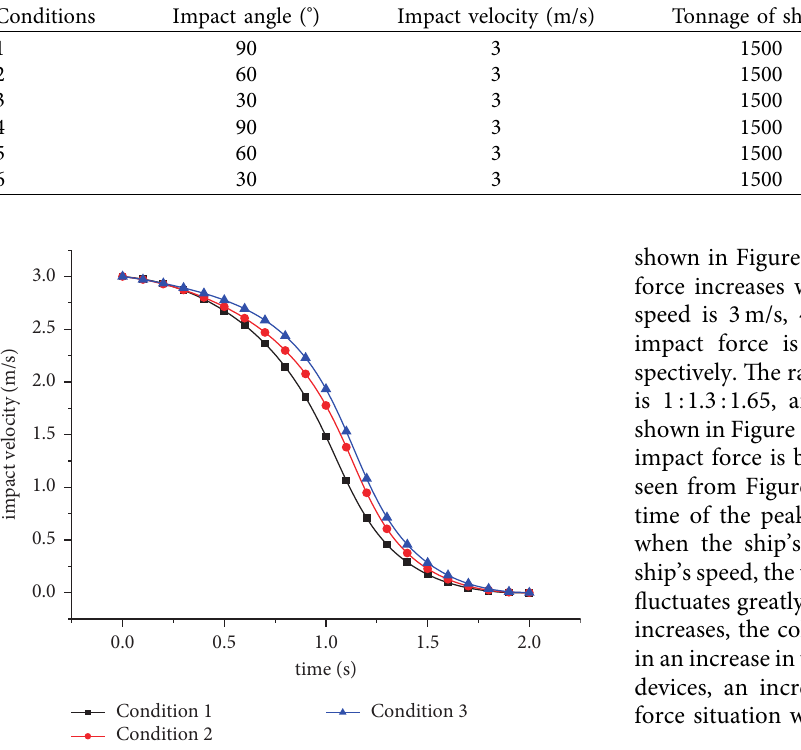
Figure 7: Velocity of impact varies with time at different